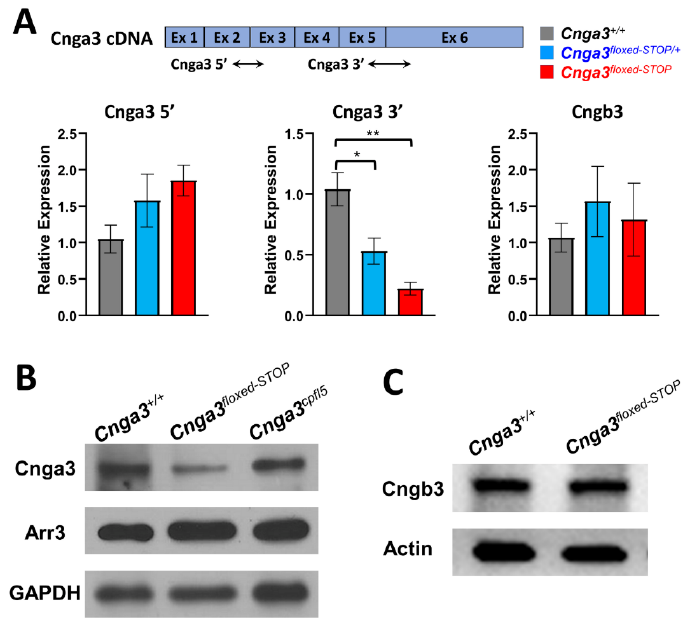
Figure 6. Quantitative Real-Time RT-PCR and Western blotting of Cnga3 floxed-STOP mice. ( A ) Two sets of primer pairs were designed to span intron 2 and intron 5, respectively, in order to identify the presence of changes in expression of Cnga3 transcript in Cnga3 floxed-STOP/+ (blue) and Cnga3 floxed-STOP (red) mice. Cnga3 +/+ littermates (grey) were included as the wild-type (WT) controls. Despite an increasing trend, the level of Cnga3 amplicon upstream of the floxed - STOP cassette lacks statistical significance, whereas the level of Cnga3 amplicon downstream of the floxed - STOP cassette was significantly reduced in Cnga3 floxed-STOP/+ and Cnga3 floxed-STOP mice. The expression of target genes was normalized to mouse Rhopdosin. Results = mean ± S.E.M (n Cnga3+/+ = 5, n Cnga3 floxed-STOP/+ = 4, n Cnga3 floxed-STOP = 3; * p = 0.0294; ** p = 0.0032). ( B ) There was reduced CNGA3 protein expression in Cnga3 floxed-STOP mice compared to littermate controls, while there was no significant decrease in CNGA3 protein expression in Cnga3 cpfl5 mice. ( C ) There was no obvious change of CNGB3 protein between Cnga3 floxed-STOP and littermate controls.